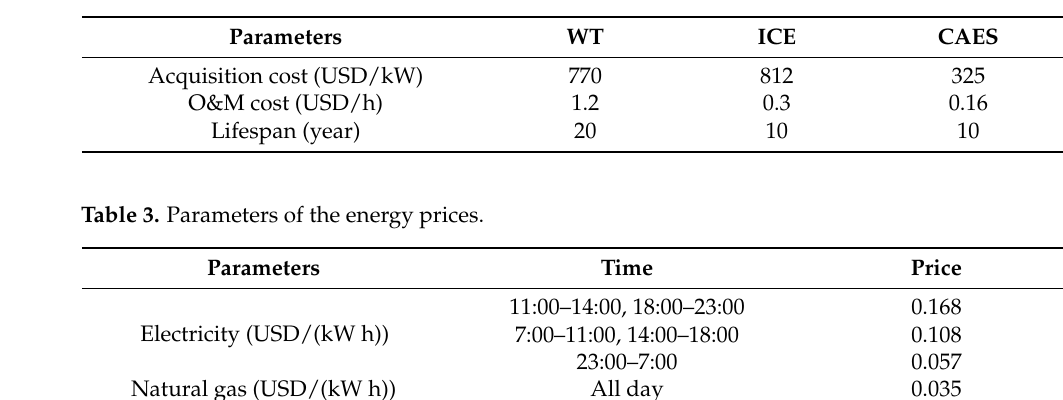
Figure 6. Inputting data in winter. In this paper, the differential evolution (DE) algorithm is used as the optimization method to find the optimal objectives. DE was chosen because this method promises sim- ple, fast, and robust optimization [32]. The authors have conducted the optimization and synthesis studies on A-CAES based on DE algorithms [33]. In this optimization, DE is employed with particular specifications (population size 500, mutation factor 0.5, and crossover factor 0.1 for optimizing the five key decision variables: the capacities of the compressors, turbines, and WTs and the operation loads of the compressors and turbines). The daily cost of the system in different seasons is the objective of the optimization in level II, and the one-day efficiency of the CAES is another system performance that is observed with each iteration when the system is optimized. As shown in Figure 7, the operation cost of the system decreases with the growing number of iterations. The one- day efficiency of the CAES is also presented along with each iteration, which increases a lot at first, to about 35% for the off-design case and 51% for the case that does not consider the off-design operation, and then, it approaches a stable value. When considering the off- design characteristics with a fixed capacity of the components, the one-day efficiency of the CAES drops to 30.4%. When employing the bi-level optimization strategy, the effi- ciency increases to 35.7% in the off-design operation. The optimal cost is the sum of the daily costs of the typical winter and summer conditions. When the off-design characteris- tics are not considered, the optimal cost of the system is USD 6882, which is lower than the cost of the system when considering the off-design characteristics; when the capacity is fixed and when employing the bi-level optimization, the costs are USD 7007 and USD 6989, respectively.